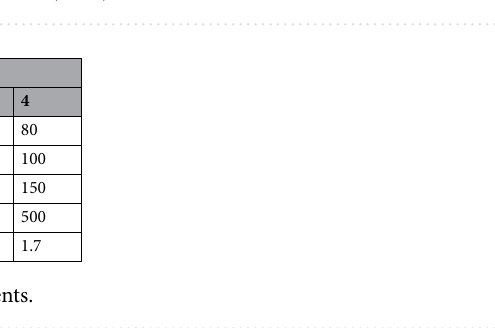
Table 6. Particle size distribution of the copper ores (Wt%).